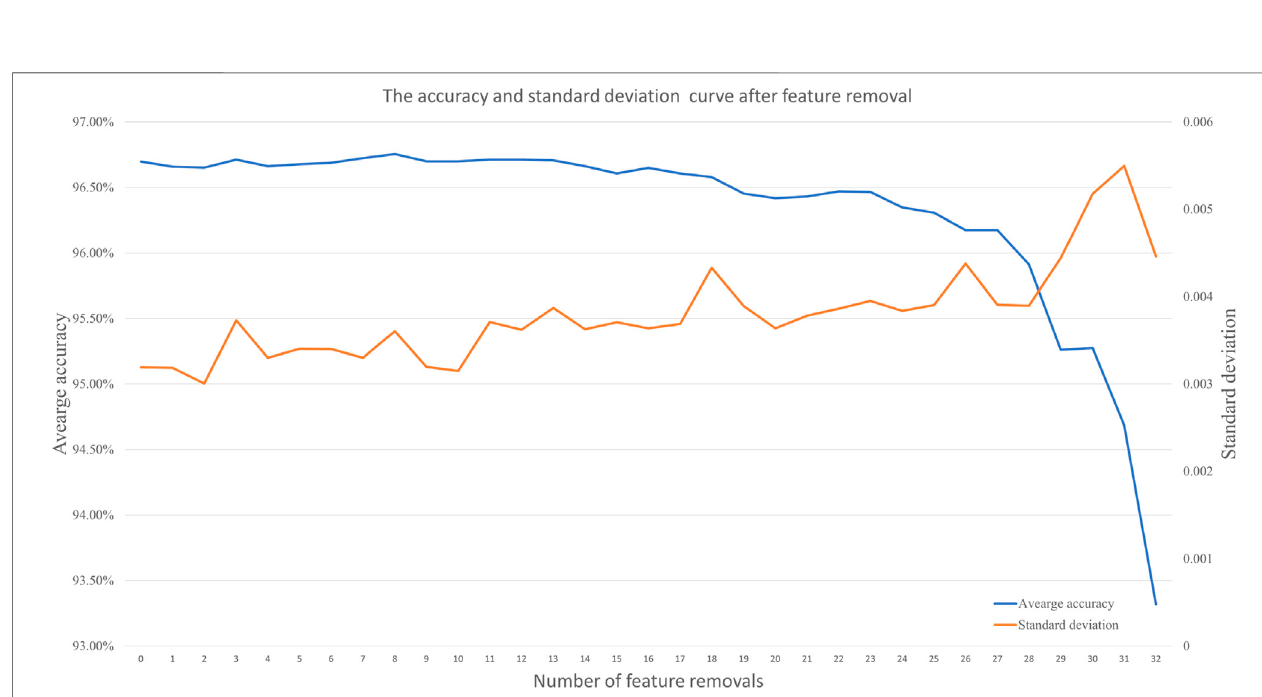
FIGURE 8 | Accuracy and standard deviation curve after feature removal. The features are removed by the importance from low to high.